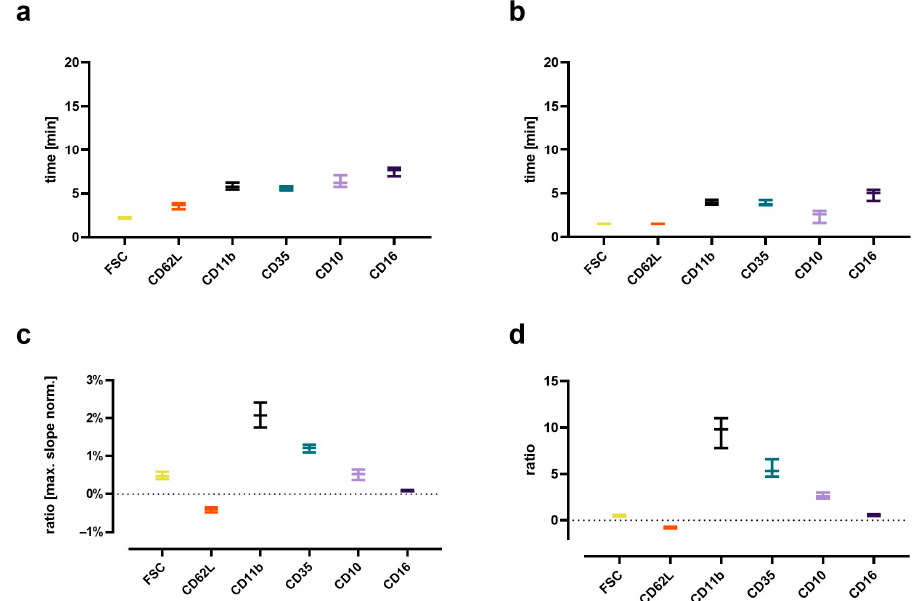
Figure 7. Analysis of the kinetics of the C5a-induced (10 nM) changes in neutrophils. ( a ) Time to when half of the maximal change in the respective value occurred, ( b ) time at the maximum slope, ( c ) maximal slope normalized to the respective baseline, and ( d ) the ratio of the change defined as the plateau 15 min after stimulation normalized to the baseline = 0. n = 7–8, median ± interquartile range.